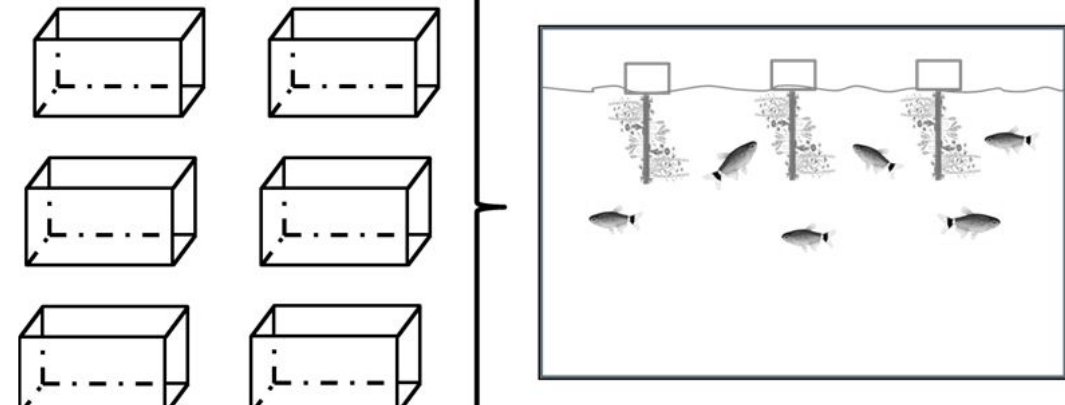
Figure 1. Schematic representation of aquariums with the colonized slides attached to a styrofoam support and individuals of the fish Moenkhausia sanctaefilomenae . Scales do not match actual sizes. In each aquarium, seven fish were included and 20 colonized glass slides were attached to a styrofoam support and inserted perpendicularly to the water